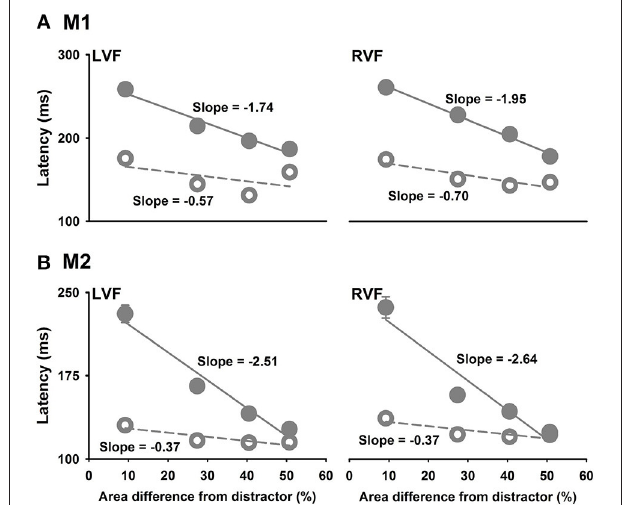
FIGURE 5 | Saccade latencies as a function of the area difference between the target and the distractor. Filled symbols are for the smaller circle target and the open symbols are for the ring target. The unit of slope is ms per 1% (A) , M1; (B) , M2.